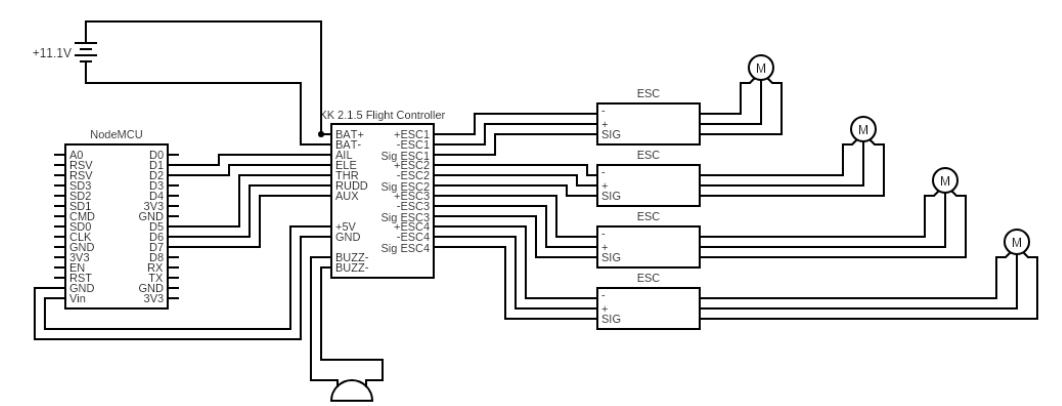
Figure 3. Circuit Diagram for Drone